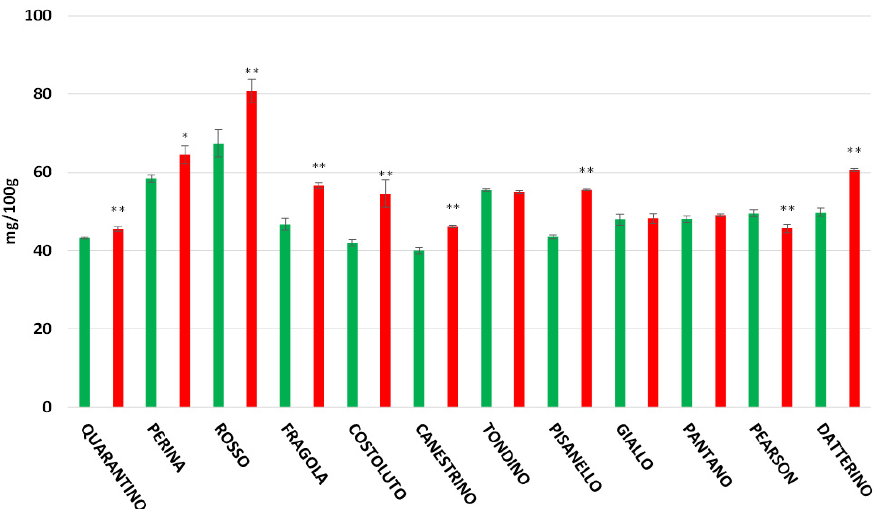
Figure 6. Total polyphenol content (expressed as mg/100 g of FW) in tomato pulp of 9 Italian cultivars and three commercial cultivars. Controls (CTRL) in green and drought-stressed group (DS) in red. The bars indicate the standard deviation. A significantly difference is shown between CTRL and DS of each cultivar by * for a p ≤ 0.05 and ** for p ≤